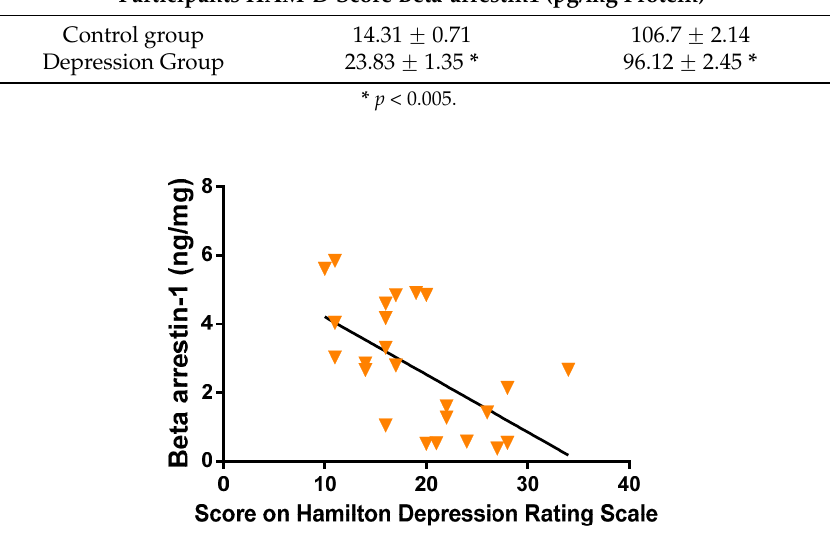
Figure 3. Correlation between beta-arrestin1 levels and the HAM-D score.